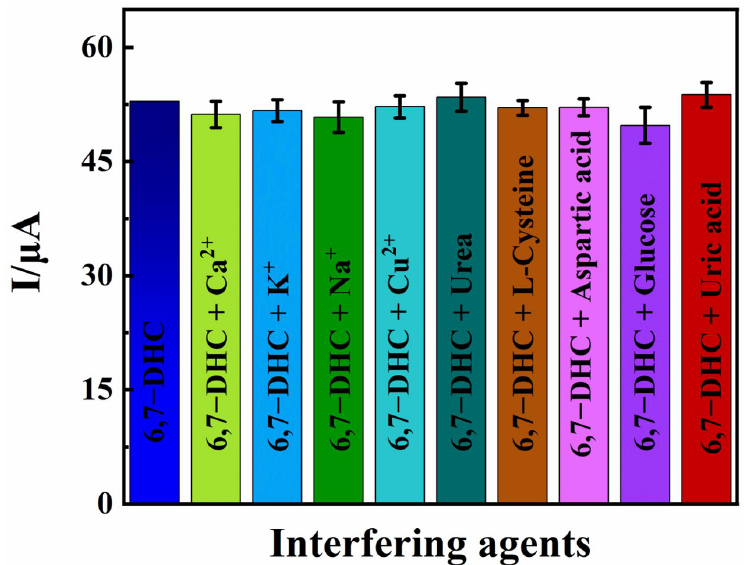
Figure 7. Influence of co-existing substances for 10.0 µ mol/L 6,7-DHC analysis (n = 3) for 100-fold concentrations of K + , Na + , Ca 2+ , and Cu 2+ and 10-fold concentrations of L-cysteine, aspartic acid, glucose, urea, and uric acid.